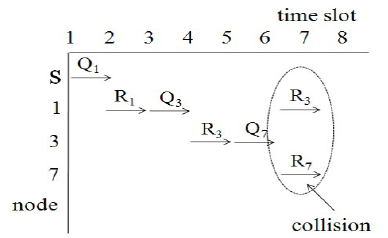
Figure 3. Transmissions in breadth-first